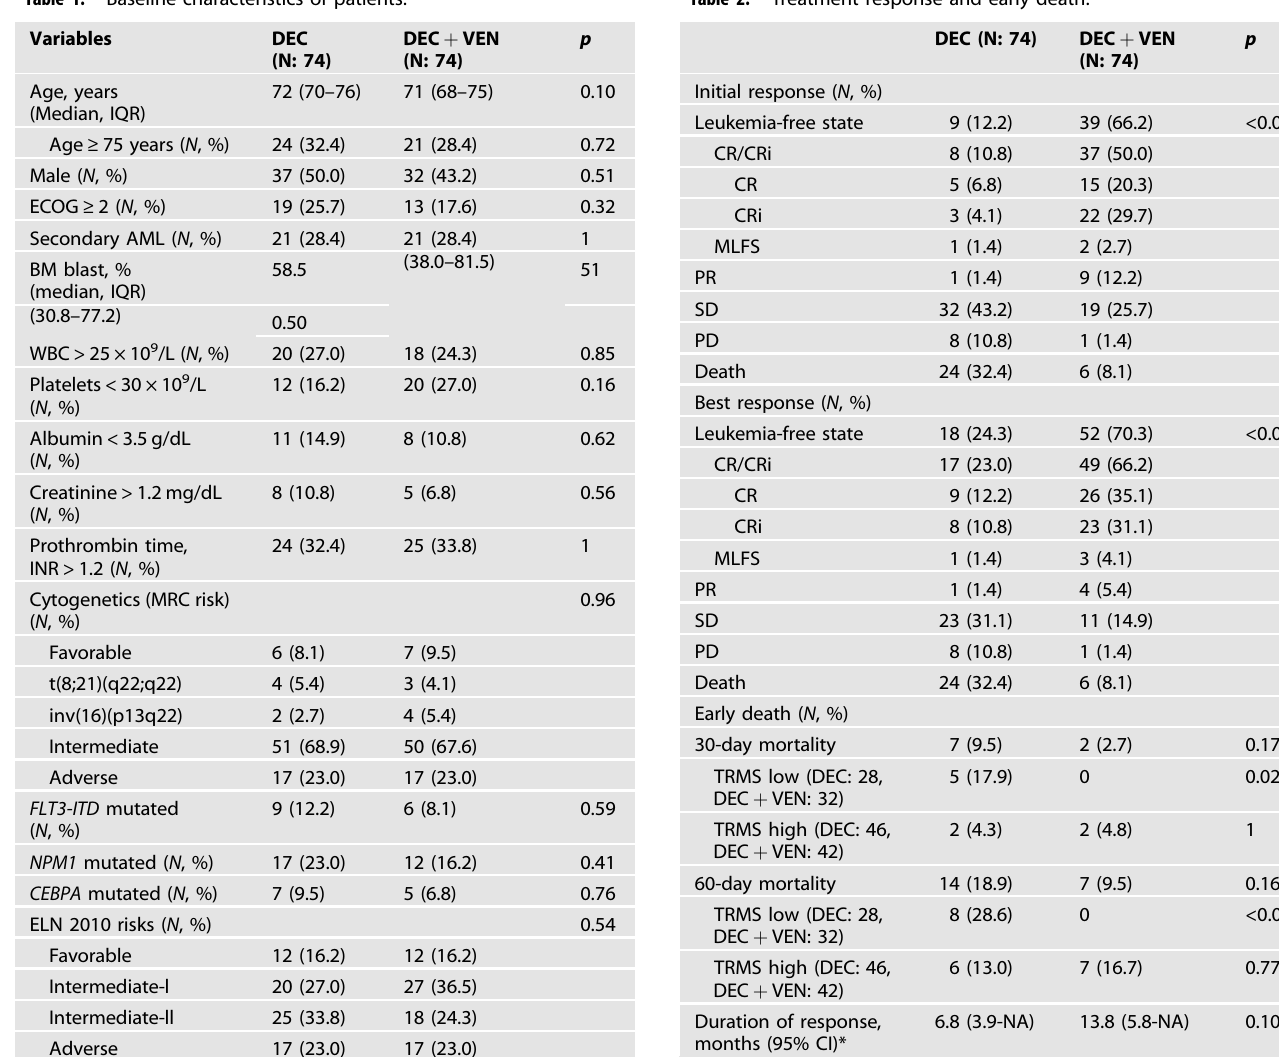
Table 1. Baseline characteristics of patients. Table 2. Treatment response and early